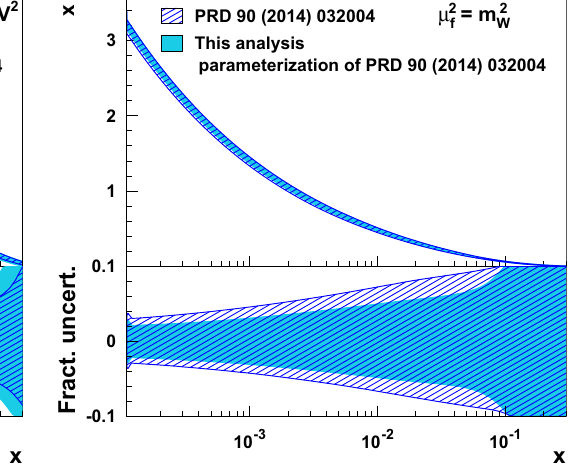
Fig. 8 The distributions of s quarks (upper panel) in the proton and current analysis (filled band) is compared to the result of Ref. [11] their relative uncertainty (lower panel) as a functions of x at the fac- (dashed band). The PDF uncertainties resulting from the fit are torization scale of 1.9GeV 2 (left) and m 2 (right). The result of the W